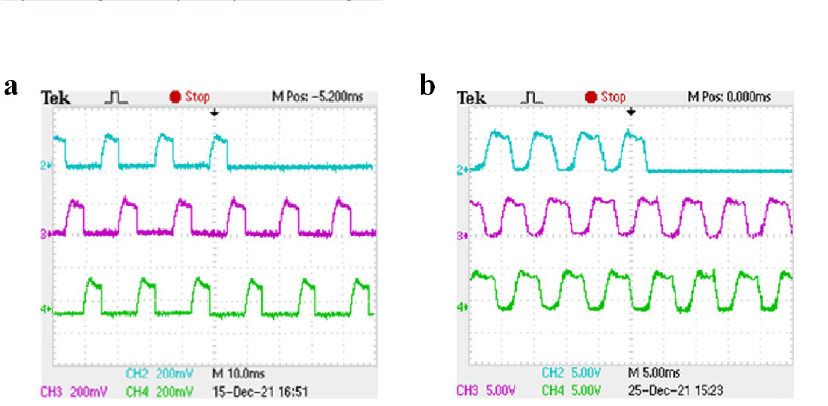
Fig 17. The open-circuit fault of A-phase SA1 experimental waveform. (a) The speed is 500 r/min. (b) The speed is 1000 r/min.